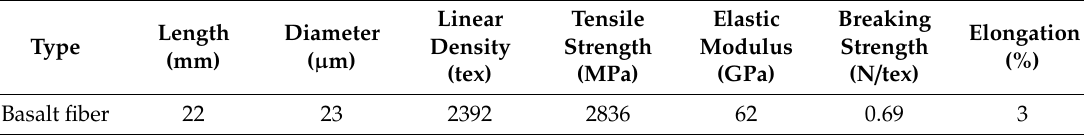
Table 4. The performance indicator of basalt